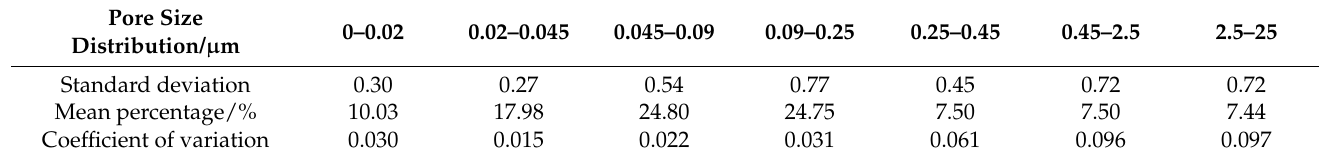
Table 2. Aperture calculation results at all